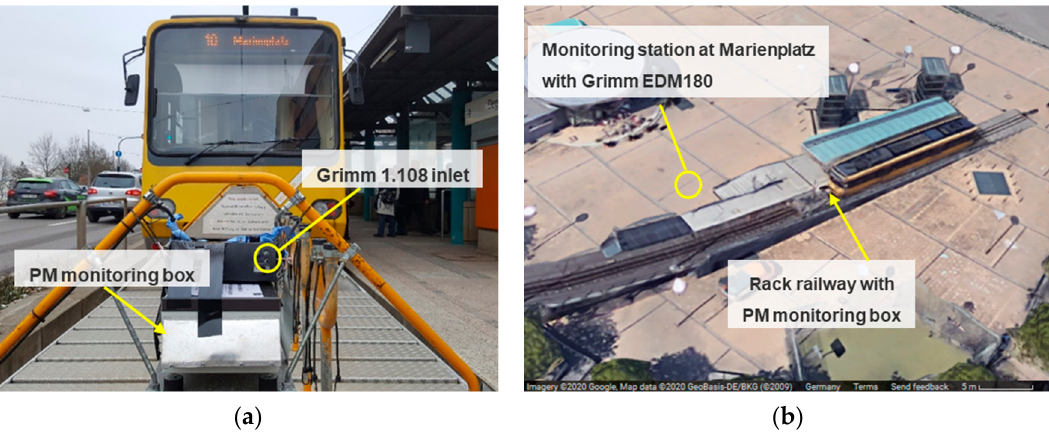
Figure 4. ( a ) The placement of aerosol spectrometer Grimm 1.108 along with the sensor-monitoring box, ( b ) The location of aerosol spectrometer Grimm EDM180 installed in the monitoring station at Marienplatz.